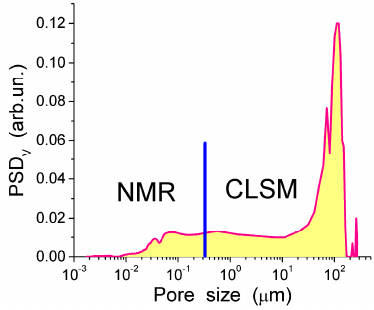
Figure 12. Pore size distribution calculated using 1 H NMR cryoporometry and CLSM methods (reproduced from Ref. [44] with permission from The Royal Society of Chemistry).